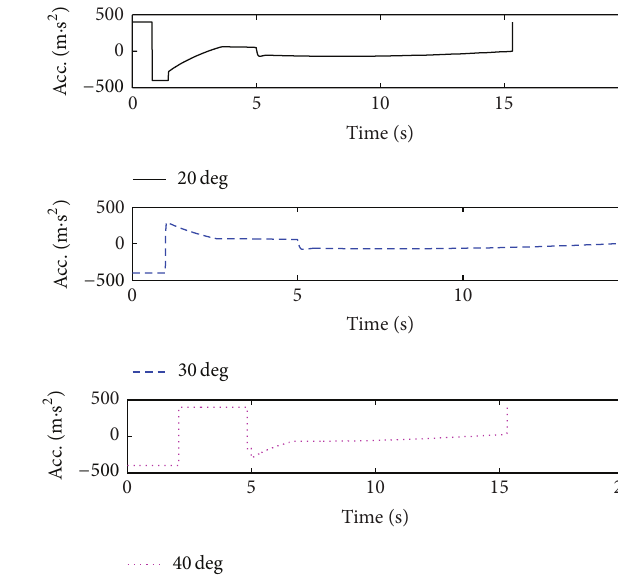
Figure 38: LOS angle.